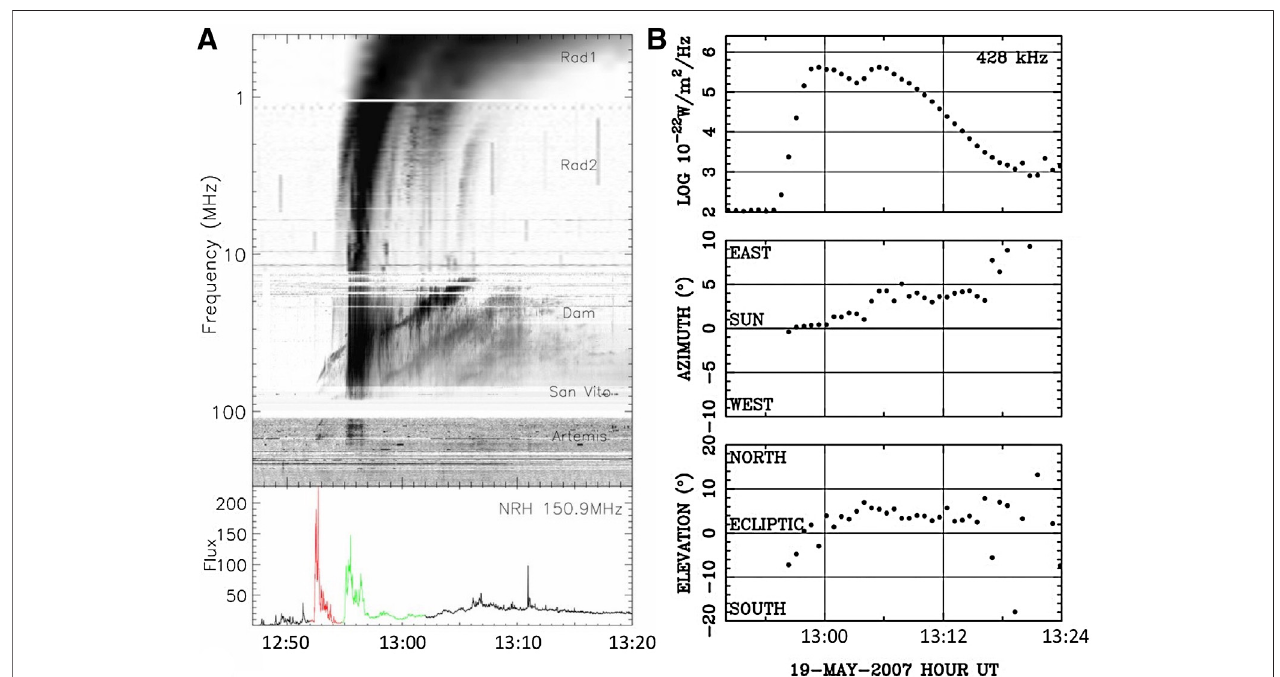
FIGURE 2 | (A) Time histories of a type III and type II burst at metre wavelengths and a complex type III burst at decametre-to-hectometre wavelengths. Dynamic spectra from dm-to-hectometre waves and time history at 150.9 MHz (bottom; type III burst in red, type II in green). (B) Time history of the type III group at 428 kHz (top panel), azimuth (middle) and elevation (bottom panel) of the source centroid as identi fi ed from the spin modulation of the Wind satellite. From Kerdraon et al. (2010). © AAS. Reproduced with